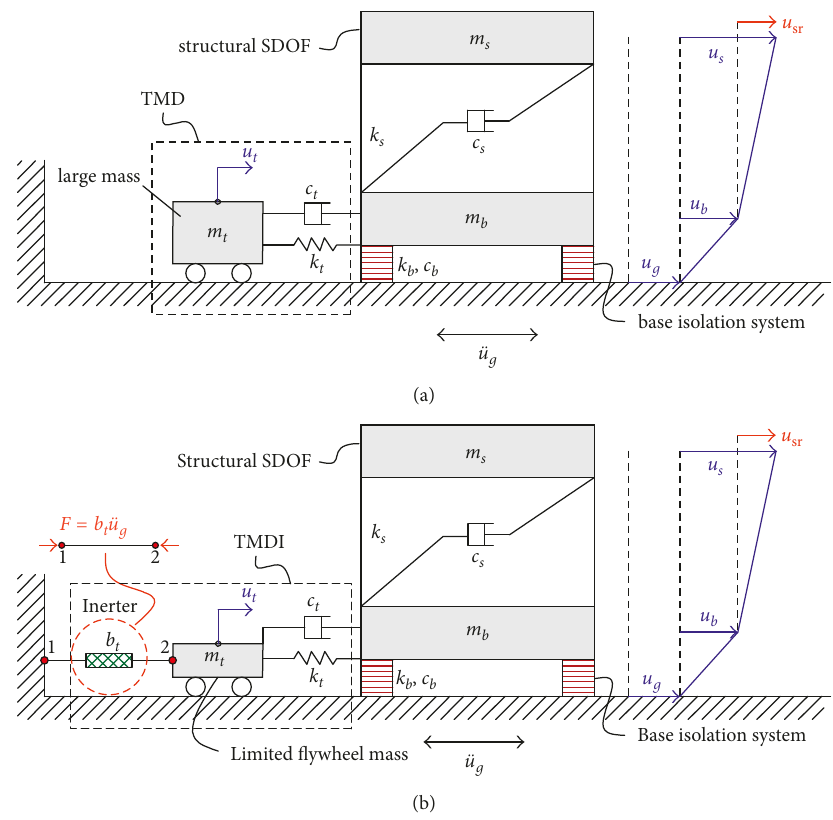
Figure 3: Sketch of base-isolated structural SDOF with attached TMD (a) and with attached TMDI